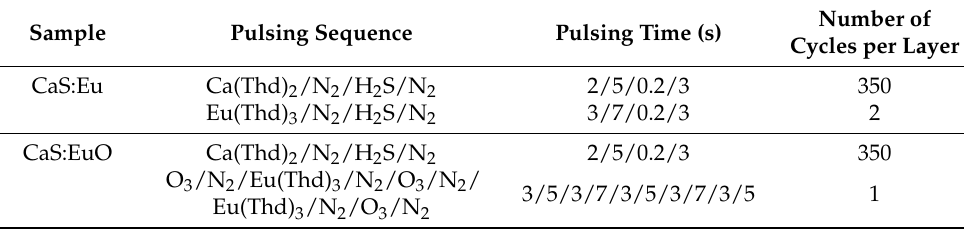
Table 1. Pulsing sequences and respective pulsing times, number of cycles per layer for CaS:Eu and CaS:EuO phosphor